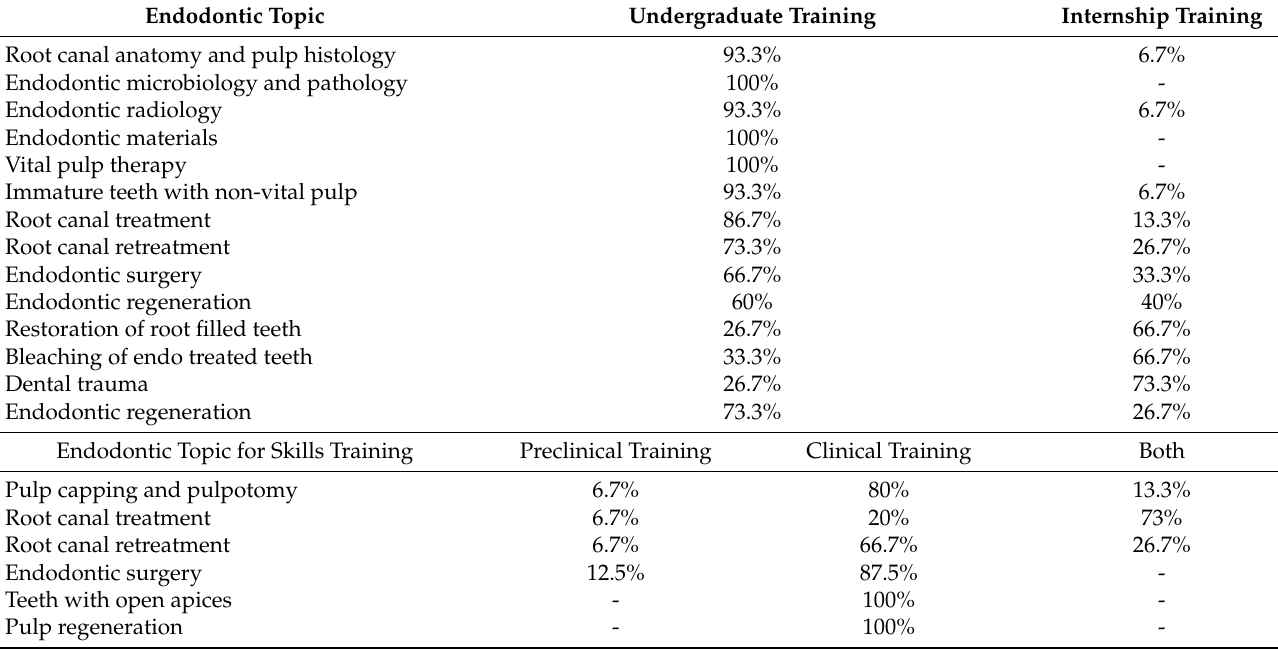
Table 1. Distribution of endodontic